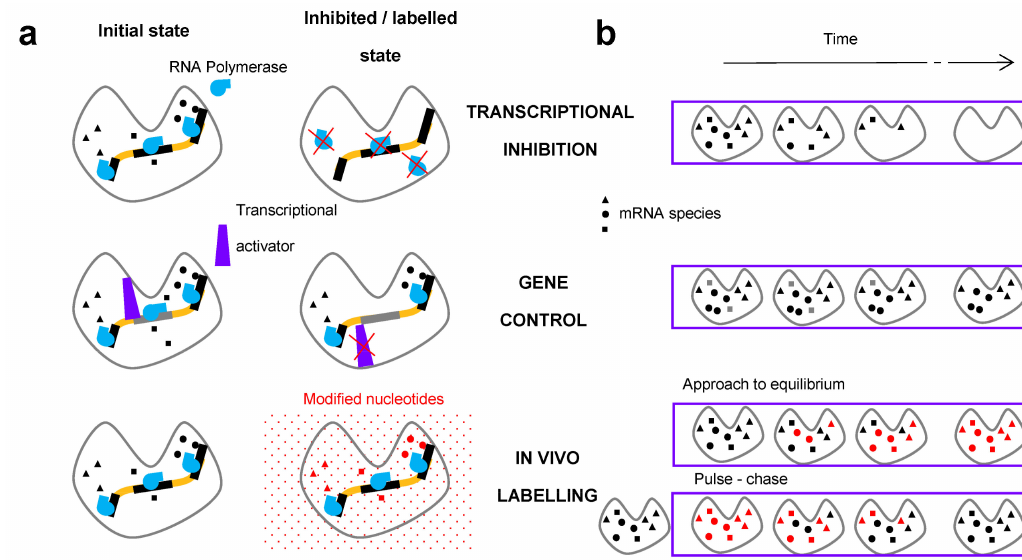
Figure 1. Main classes of methods to study RNA stability. ( a ) Scheme of the molecular mechanism affected by the specific method procedures. In transcriptional inhibition, the RNA polymerase is inactivated; the expression of all genes is reduced. In the gene control method, a transcriptional activator dissociates from a specific promoter, shutting off the expression of the specific gene under the control of this promoter. For labelling of the RNAs, modified nucleotides are introduced into the cell (red dots), which are then incorporated into the RNA; ( b ) Time course of the experiments to determine RNA half-lives. Inhibition of transcription of the gene(s) is triggered at t = 0 in transcriptional inhibition and gene control methods. There are two subclasses of the in vivo labelling. In the approach to equilibrium method, a pulse of modified nucleotides is applied and the increase of the labelled mRNA is monitored. In the pulse–chase method, the RNA is first labeled (pulse period). During the chase period starting at t = 0, the labeled nucleotides are washed out and replaced with unlabeled nucleotides and the decline of the labelled RNA is